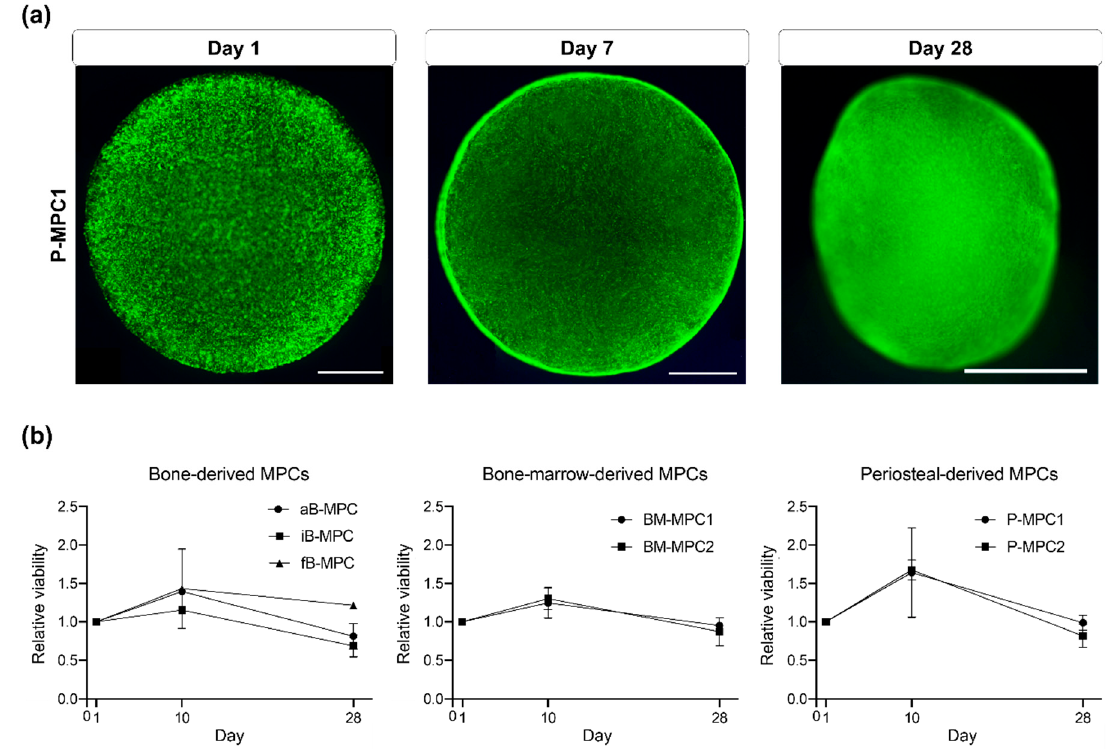
Figure 3. Viability of cells in bioprints. ( a ) Fluorescence microscopy images of propidium iodide/fluorescein diacetate stained constructs showing living cells in green and dead cells in red on days 1, 7, and 28. Representative images shown for P-MPC1. Scale bar = 1000 µm. ( b ) Results of alamarBlue TM assay on days 1, 10, and 28 of cultivation. Viability was normalized to the respective value for each cell type on day 1. n = 2.